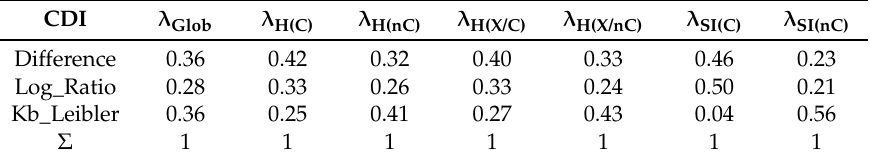
Table 3. DS1, Weights ( λ ) corresponding to CDI Information (metric)